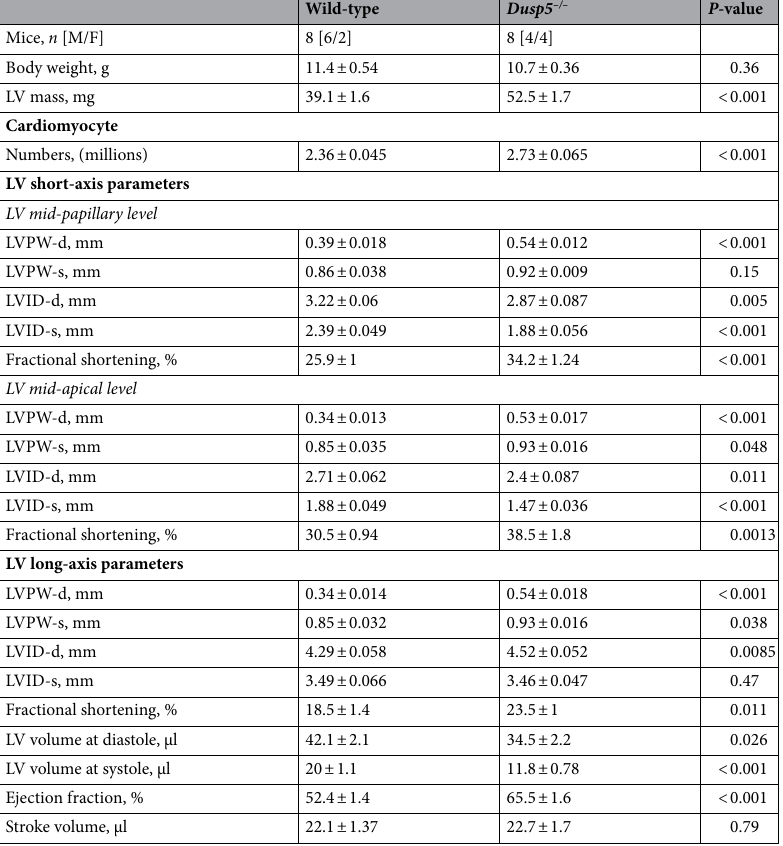
(2.16 ± 0.033 × 10 6 cardiomyocytes in scrambled siRNA + T3-treated mice versus in 2.22 ± 0.041 × 10 6 cardio- myocytes in scrambled siRNA + vehicle-treated mice; n = 10/group; P = 0.27). In 5-week-old mice, acute DUSP5 siRNA, but not scrambled siRNA, reduced cardiomyocyte DUSP5 levels by > 99% ( P < 0.001) (Supplementary Fig. S2). These pharmacological studies suggest that DUSP5 expression in cardiomyocytes inhibits the in vivo proliferative effects of exogenous T3 on these cells. DUSP5 regulates hyperplastic heart growth in preadolescent mice. We have previously shown, using propylthiouracil (PTU) to inhibit T3 biosynthesis, that increases in endogenous circulating T3 during early preadolescence stimulate cardiomyocyte proliferation 1 . Could the presence of DUSP5 in these young hearts limit hyperplastic heart growth at this developmental stage? We therefore compared the cardiomyo- cyte endowment and cardiac morphology of 21-day-old Dusp5 –/– C57BL/6 mice 16 with age-matched wild-type C57BL/6 mice. Dusp5 –/– mice had similar body weights to wild-type mice, but their ventricular cardiomyocyte numbers were 16% higher ( P < 0.001) (Table 1). In comparison to wild type mice, Dusp5 –/– mice had 40%–60% thicker LV posterior walls (LVPW), at end-diastole, at the mid-papillary and mid-apical-levels as well as at the apex ( P < 0.001) (Table 1). The mid-apical level is mid-distance between the mid-papillary level and the LV apex. Values for the mid-papillary and mid-apical levels were derived from short-axis measurements, whereas those for the apex were derived from long-axis measurements. Assessments, at end-diastole, of LV internal dimension (LVID-d) at the mid- papillary level and the mid-apical level indicated that the LV chamber of Dusp5 –/– mice was narrower (by ~ 11% at both the mid papillary and mid-apical levels; the respective P -values were 0.005 and 0.011) and longer (LVID-d-long axis) (by 5%, P = 0.009) (Table 1). In these P21 Dusp5 –/– hearts, LV fractional shortening was ~ 8 points higher ( P < 0.001) with respect to the short axis and ~ 5-points higher with respect